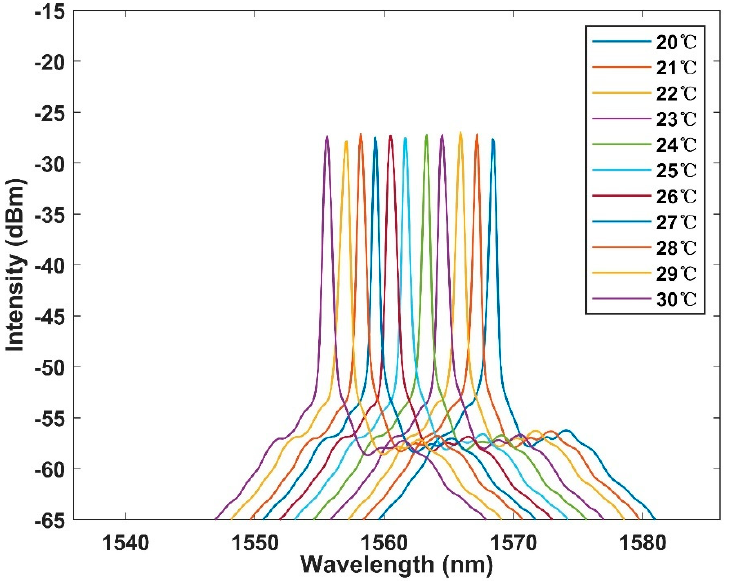
Figure 10. Different output spectra of the laser, varying with temperature (20 °C–30 °C; interval is 1 °C).